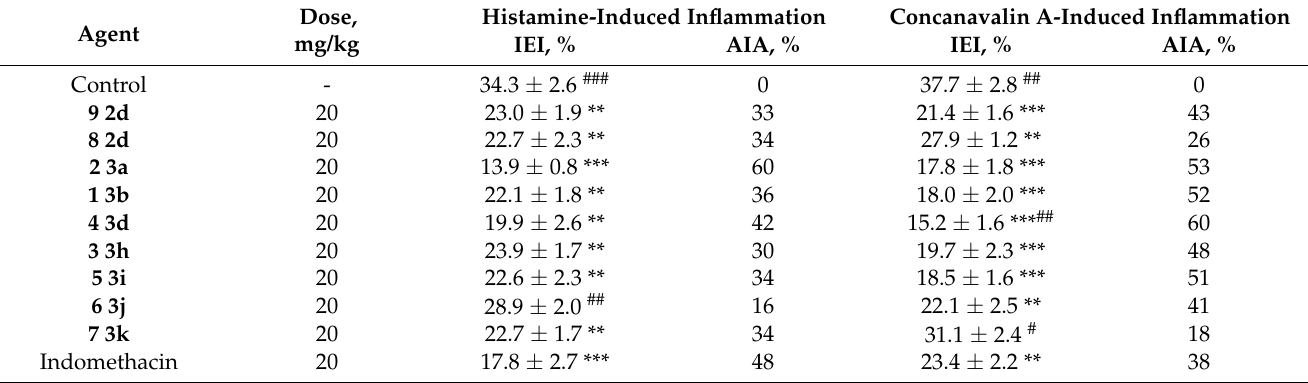
Table 1. Anti-inflammatory activity of tested substances in mouse paw edema